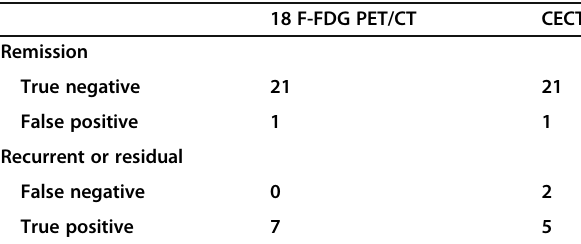
Table 2 Group A ( n =29) follow-up imaging results (correlation with final diagnosis) 18 F-FDG